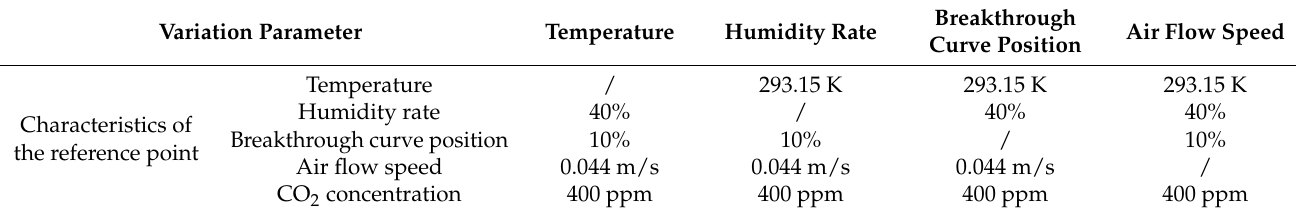
Table 7. Reference points for the different parametric